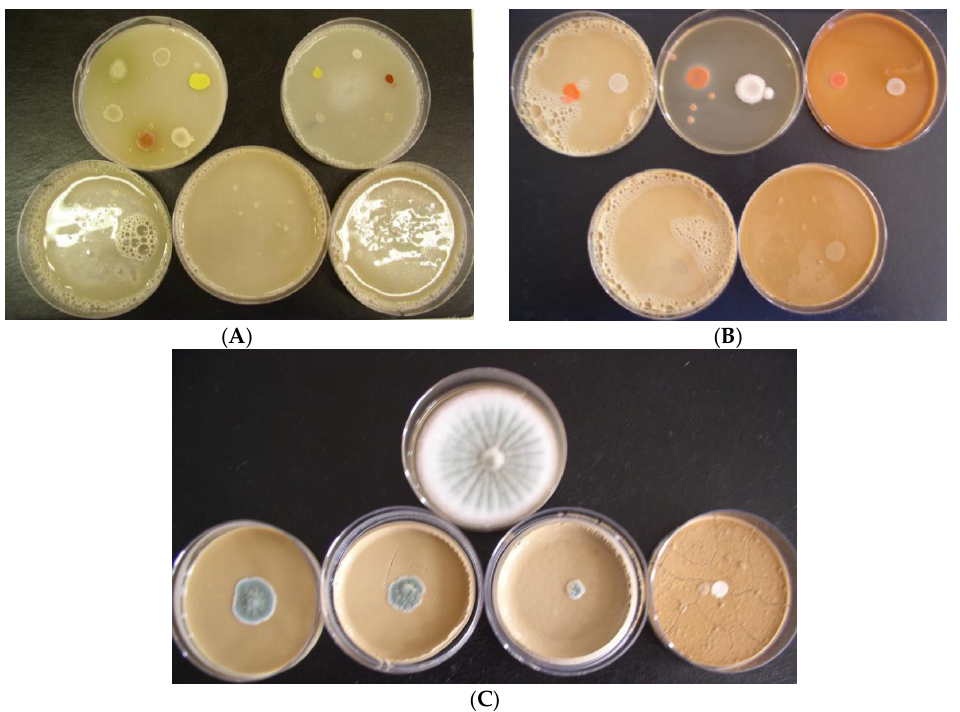
Figure 1. View of the testing arrangement in Petri dishes regarding the growth inhibition of selected representatives of biodeteriogenic microflora in the presence of tested slags: ( A ) inhibition of bacteria growth in the presence of slag S4 with alkaline pH of the growth media (upper line from left: control (no slag), slag S4—10%; lower line from left: slag S4—20%, 40%, 60%); ( B ) inhibition of yeasts growth in the presence of slag S1a at neutral pH (N) and alkaline pH (A) of the growth media (upper line from left: slag S1a (A)—10%, control (no slag), slag S1a (N)—10%; lower line from left: slag S1a (A)—60%, S1a (N)—60%); and ( C ) inhibition of Penicillium funiculosum growth in the presence of slag S1a at alkaline pH (A) of the growth media (upper line: control (no slag), lower line from left: slag S1a (A)—10%, 20%, 40%, 60%).